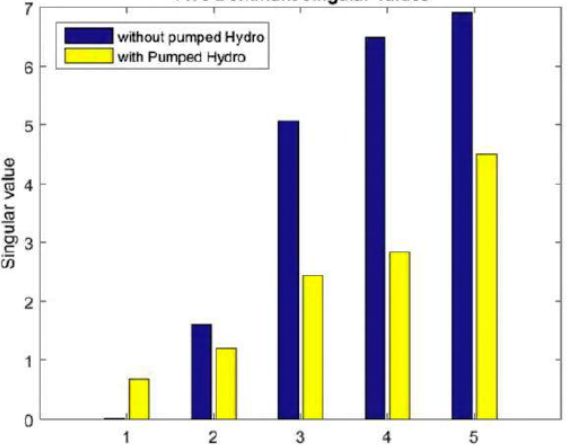
Figure 11. Result plot with and without PHG: Period 3.